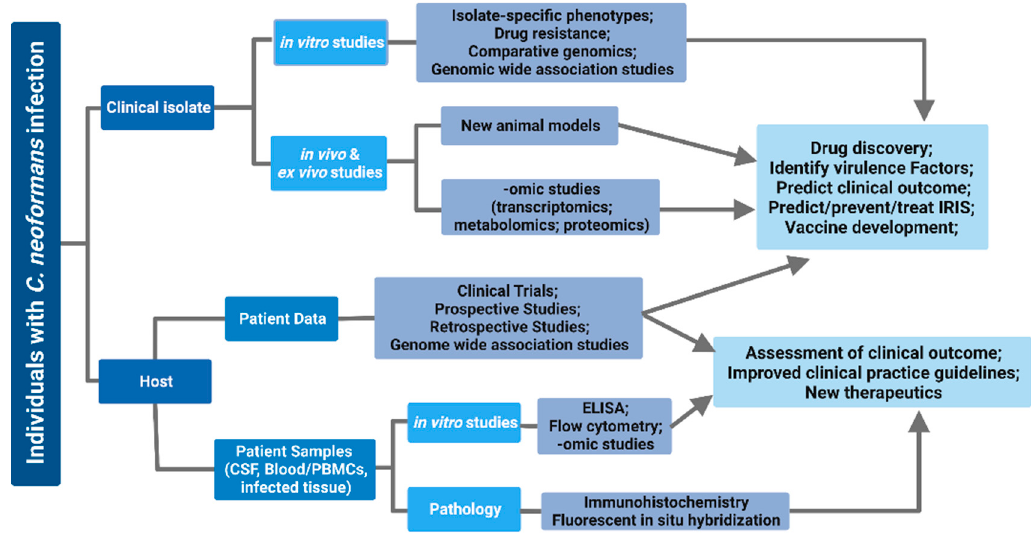
Figure 2. Experimental strategy to study host–pathogen interactions using C. neoformans clinical iso- lates.